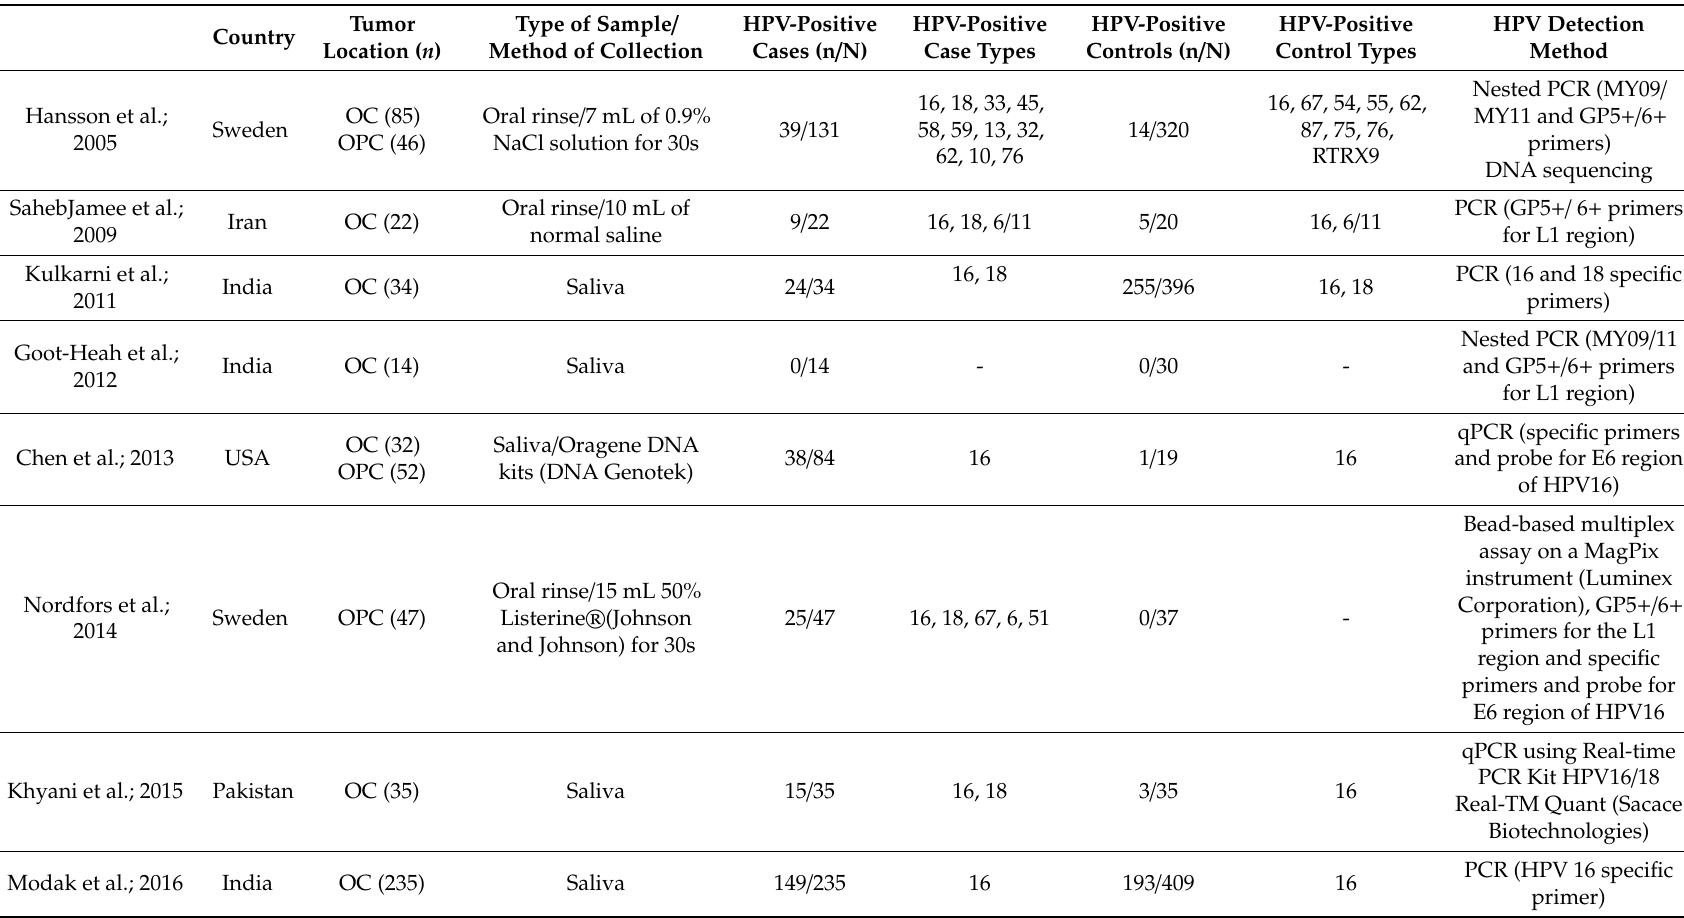
Table 1. Characteristics of the 14 case-control studies included in this